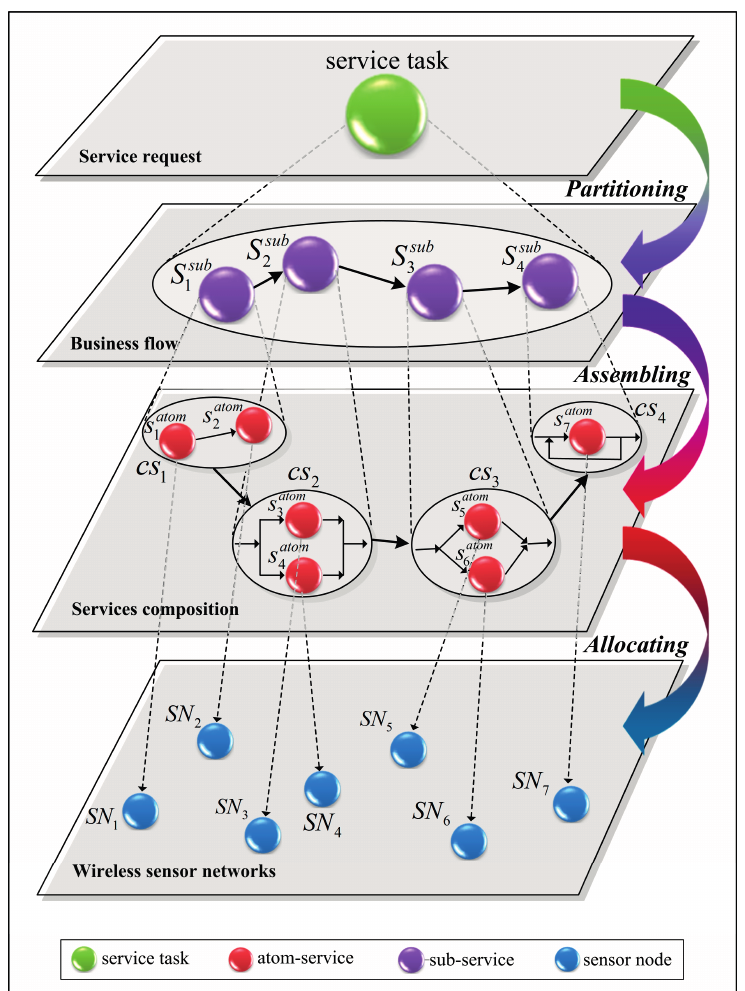
Figure 2. Working mechanisms of the WSN service